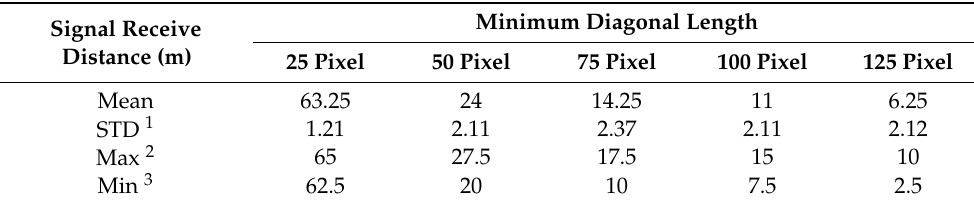
Figure 12. Visual warning via the LED strip and the three-color LED from the AI smart helmet. ( a ) Helmet wearer before the vehicle reaches hazardous area; ( b ) Helmet wearer when the vehicle reaches the hazardous area. Table 2. Results of the recognition distance (m) of the AI smart helmet according to the input minimum diagonal length (pixels).